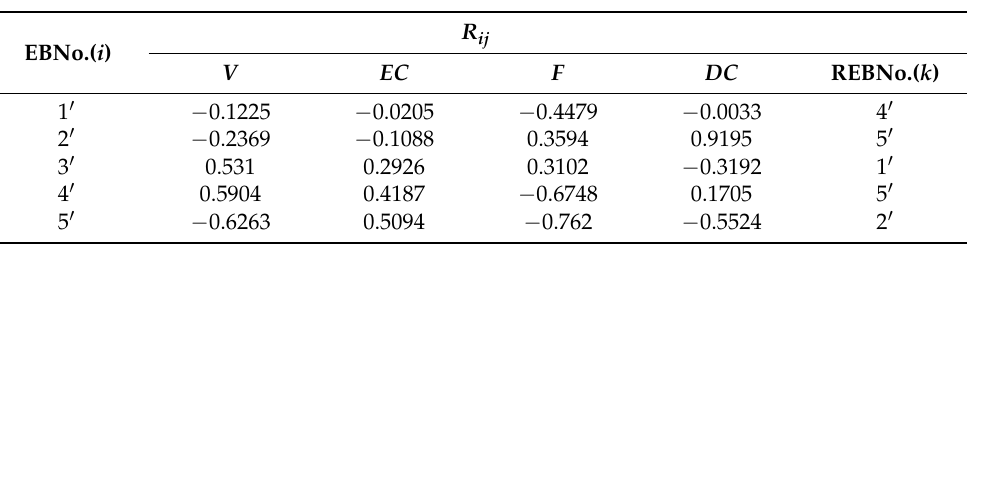
Table A7. Random number and selected bee for new